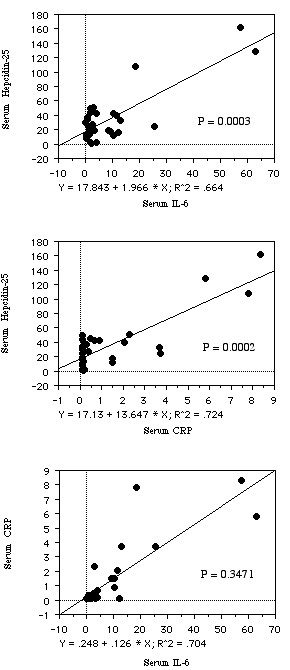
Spearman rank correlation coefficient relationship between serum concentrations of hepcidin-25, IL-6, and CRP.